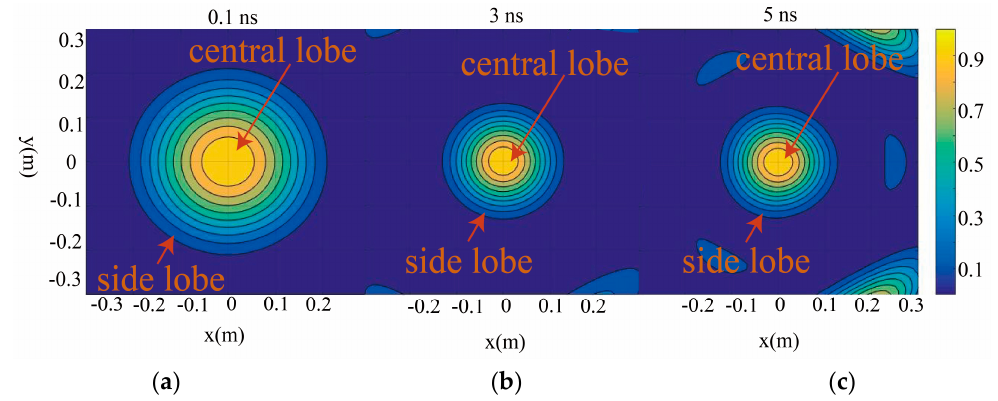
Figure 5. Array focus effect figures at different moments: ( a ) top view at t = 0.1 ns, ( b ) t = 3 ns and ( c ) = 5 t = 5 ns. ( c ) t